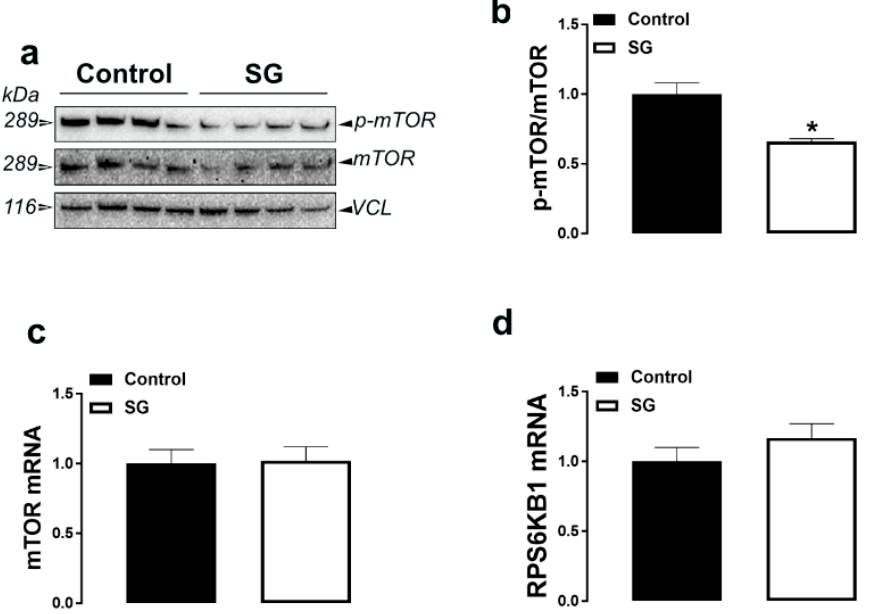
Figure 5. Effect of the phytogenic water additive AVSSL on the expression of protein metabolism- associated proteins and genes in breast muscle tissue. Protein levels of phosphorylated mTOR, mTOR, and VCL ( a , b ) were measured by Western blot and mRNA abundances of mTOR and RPS6KB1 ( c , d ) were determined by qPCR using the 2 −∆∆ Ct method [21]. Data are presented as the mean ± SEM ( n = 8 birds/ group). * Denotes significant difference compared to the control group at